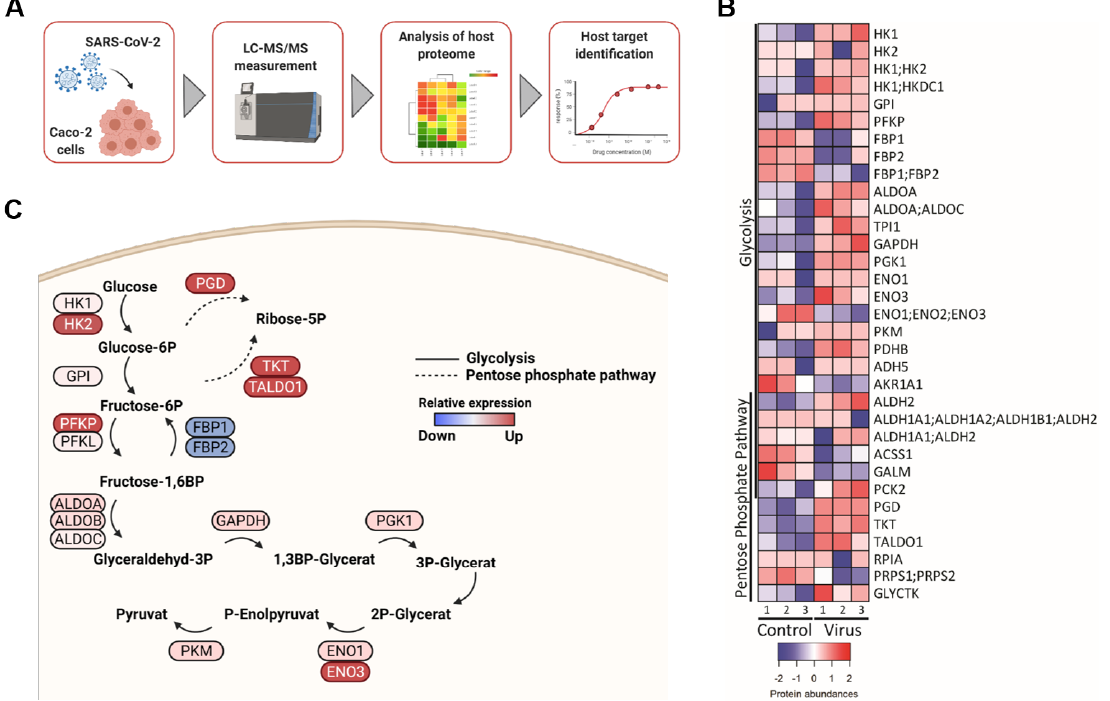
Figure 1. Glycolysis and pentose phosphate pathway (PPP) are deregulated during SARS-CoV-2 infection. ( A ) Schematic of proteomic analysis of SARS-CoV-2 infected Caco-2 cells. ( B ) Heatmap of changes in protein abundance of components of glycolysis and pentose phosphate pathway in SARS-CoV-2 infected Caco-2 cells at 24 h post infection. A Z score transformation was performed such that red and blue represent high and low protein abundance, respectively. The plot was performed using the heatmaps2 function of the gplots package of the R suite. ( C ) Pathway depiction of main regulators of glycolysis and PPP using BioRender.